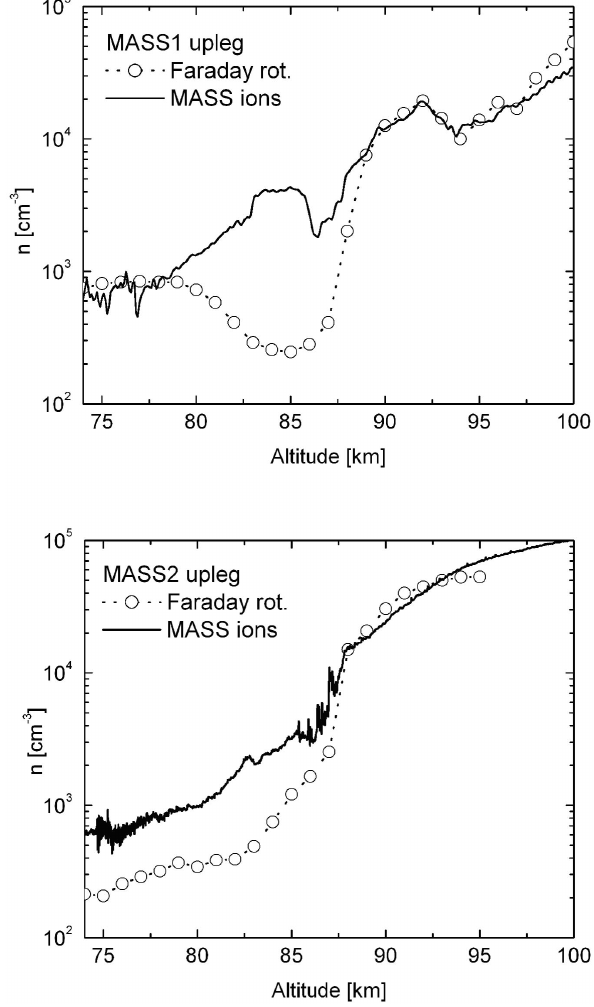
Fig. 5. The electron density from Faraday rotation for MASS1 (up- per panel) and MASS2 (lower panel) are plotted with the positive ion density indicated by MASS analyzer channel 1+ for the light- est positive particles. In the data analysis for the MASS channel, a collection efficiency of 0.64 is used from the simulations with − 1V payload potential for NO+ at